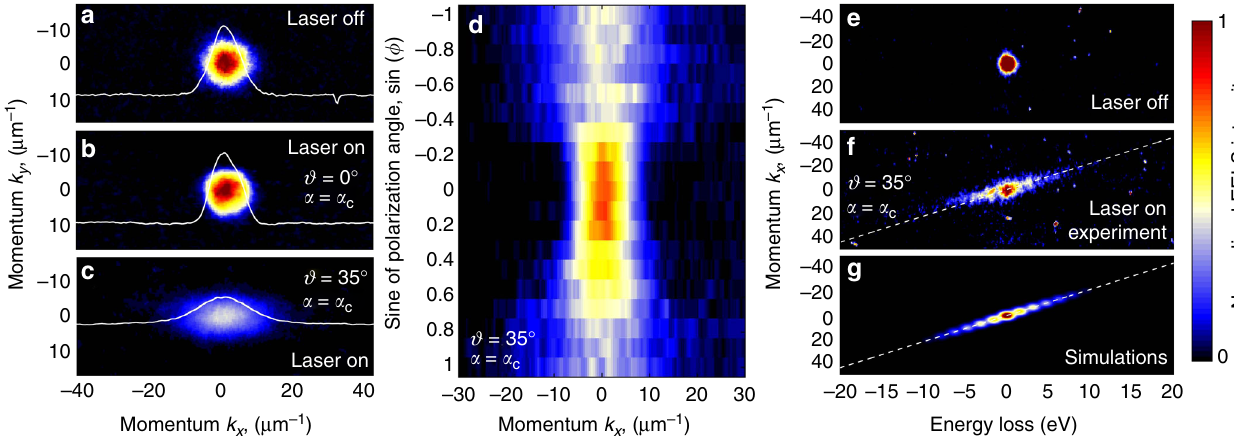
Fig. 3 Momentum exchange during electron – light interaction. a Direct electron beam measured in the diffraction plane as a function of transversal momentum ( k x , k y ) when no light is applied. b , c Same as a under illumination with 560 fs laser pulses of 11.1 × 10 7 V/m peak fi eld amplitude and α = α C . The ϑ tilt angle is 0° in b and 35° in c . A clear streaking of the electron beam appears along the k x direction in c as a result of momentum exchanges between light and electrons. d Electron-beam pro fi le along k x as a function of light polarization (sin ϕ = 0 for s-polarization and sin ϕ = ±1 for p-polarization). e Direct electron beam measured in the momentum-energy plane k x − E in the absence of optical illumination. f , g Measured ( f ) and simulated ( g ) momentum-energy maps for illumination under the conditions of